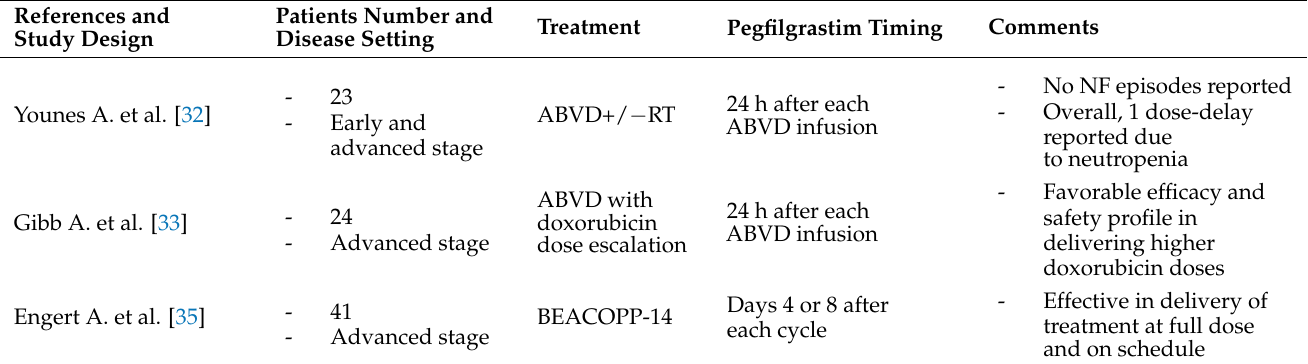
Table 1. Summary of reported data on